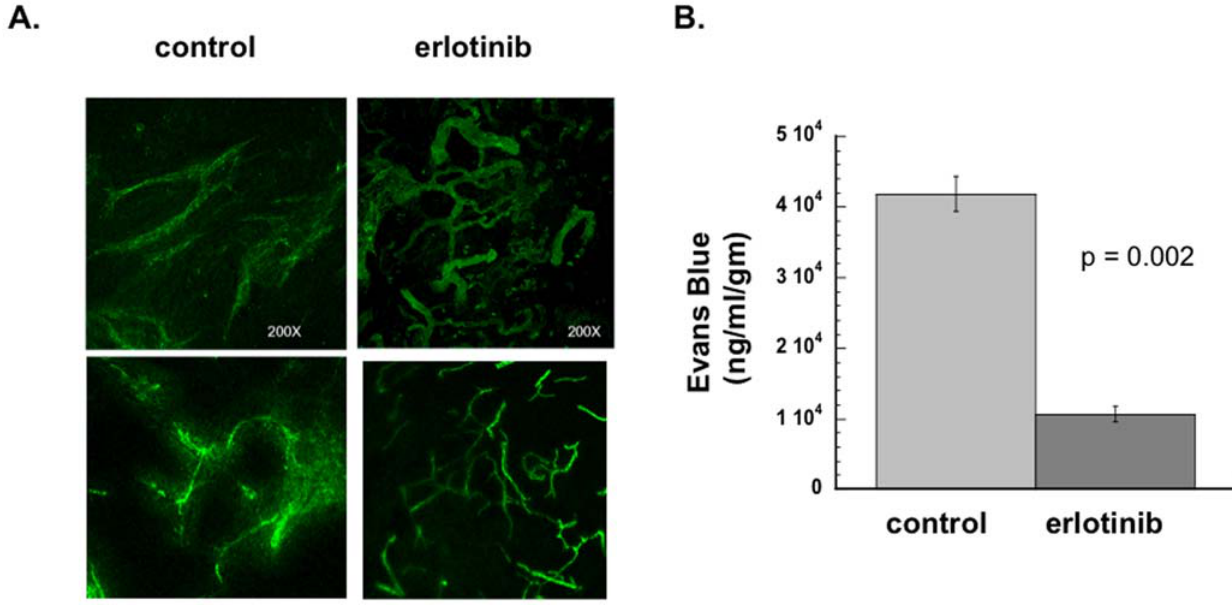
Figure 2. Erlotinib alters vascular morphology and increases vascular permeability invivo . (A) Nude mice were injected subcutaneously in the flank with SQ20B cells to form xenografts. When tumors reached a size of , 1 cm in diameter, some of the mice were started on an erlotinib- containing diet (50 mg/kg/day). After 4 days of erlotinib treatment (or control diet), FITC-conjugated tomato lectin was injected via tail vein. The mice were euthanized, and then a 100 m m thick section of each tumor was viewed under confocal microscope. The projected photomicrograph (200 6 total magnification) of sections of tumors from 2 different erlotinib-treated and 2 control mice are shown (B) Tumors were grown as described in (A). Evans blue dye was injected intravenously. Six hours later mice were sacrificed and tumors were excised. Dye was extracted, then quantified by reading at 620 nm in a spectrophotometer. Data shown represent mean of 3 control mice and 3 erlotinib-treated mice. Error bars represent standard error of the mean. p value was obtained using Student’s